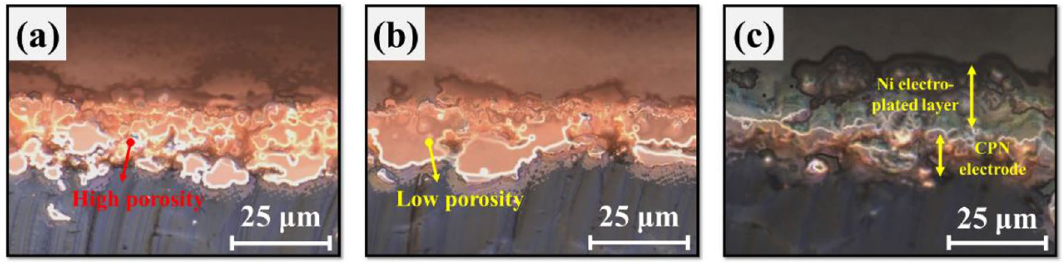
Figure 8. Cross-sectional observation of an ( a ) IPL sintered Cu NPs electrode, ( b ) IPL sintered CPN electrode, and ( c ) Ni electroplated CPN electrode (S-16).